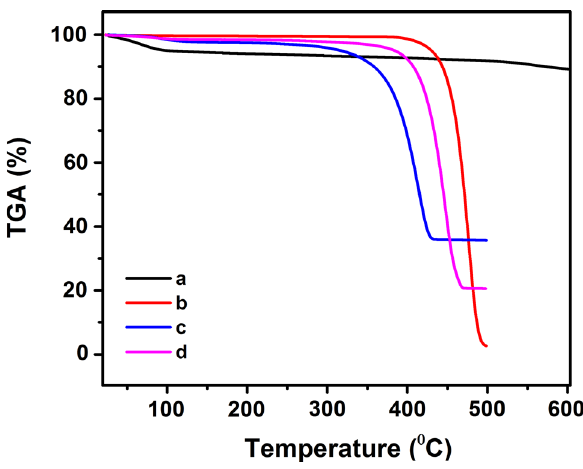
Fig. 5 TGA diagram of pure green clay ( a ), pure polyethylene ( b ), green clay + polyethylene (composite) ( c ), green clay + polyethyl- ene + methylene blue ( d